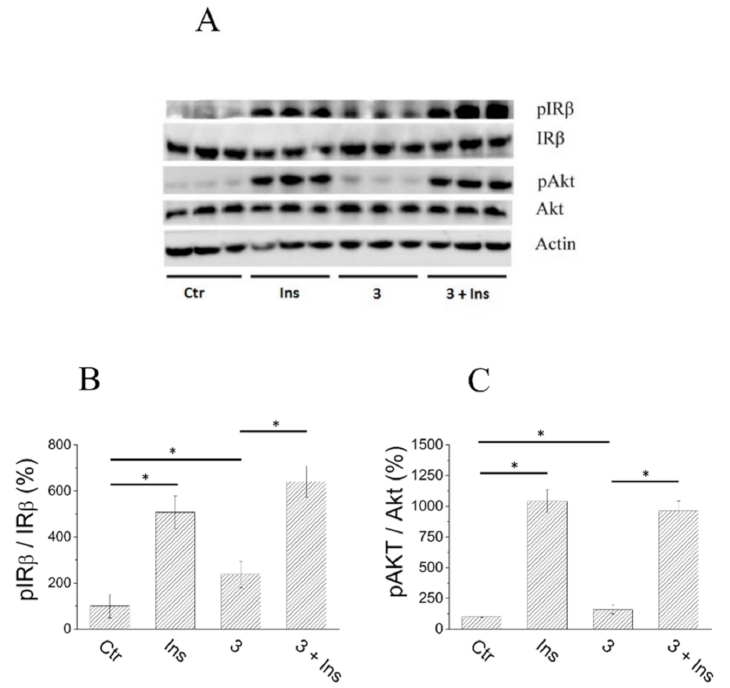
Figure 12. Effect of compound 3 on insulin signalling pathway. C2C12 cells were incubated with compound 3 (20 µ M final concentration) for 30 min, in the presence or not of insulin (10 nM).